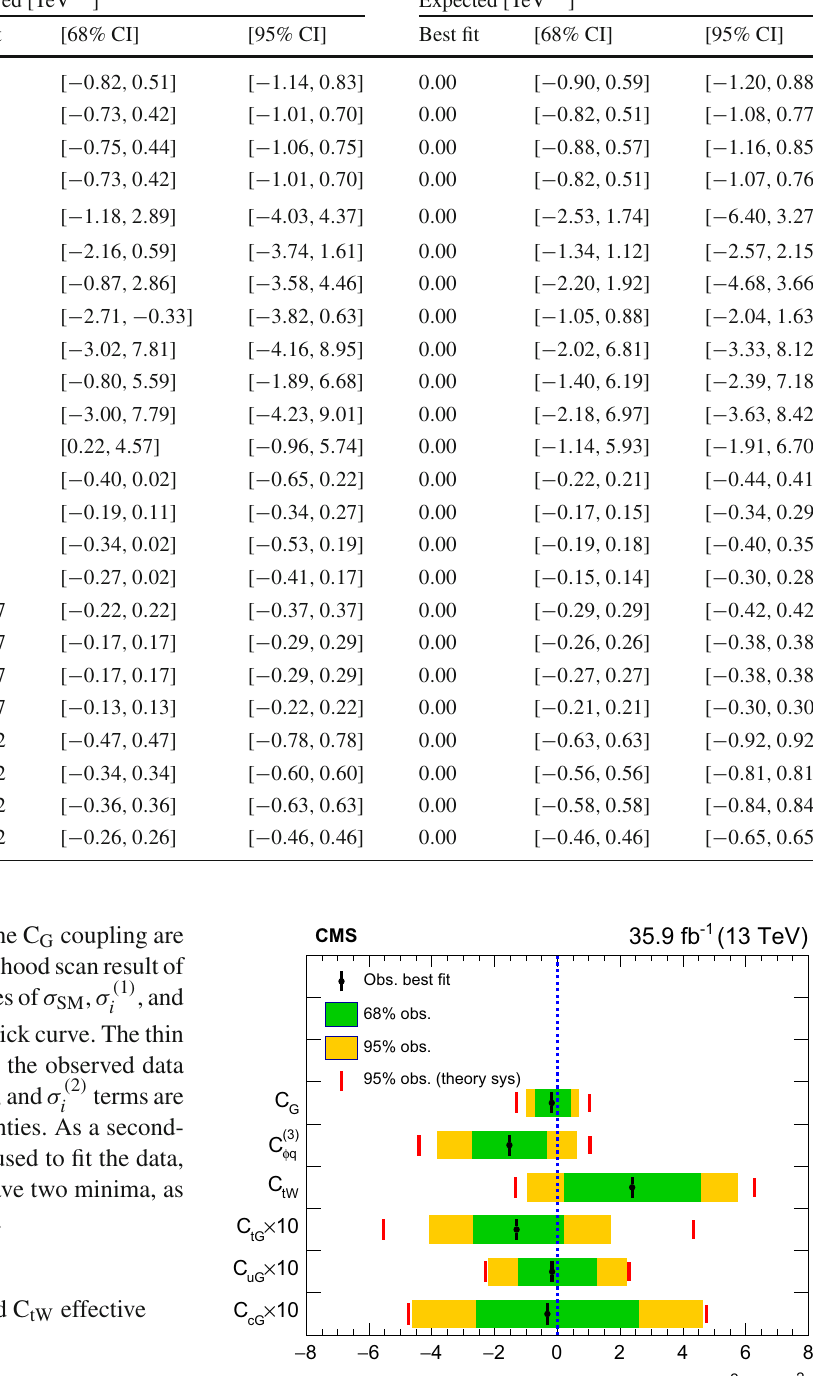
Table 5 Summary of the observed and expected allowed intervals on the effective couplings obtained in the ee, e μ , and μμ channels, and all channels combined. All sources of systematic uncertainty, described in Effective coupling